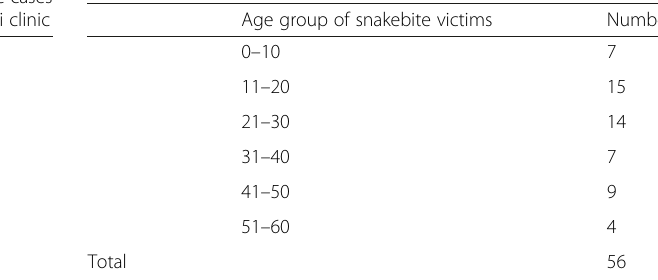
Table 3 Age group distribution of snakebite cases reported at Meserani clinic, Arusha, in 2012 Age group of snakebite